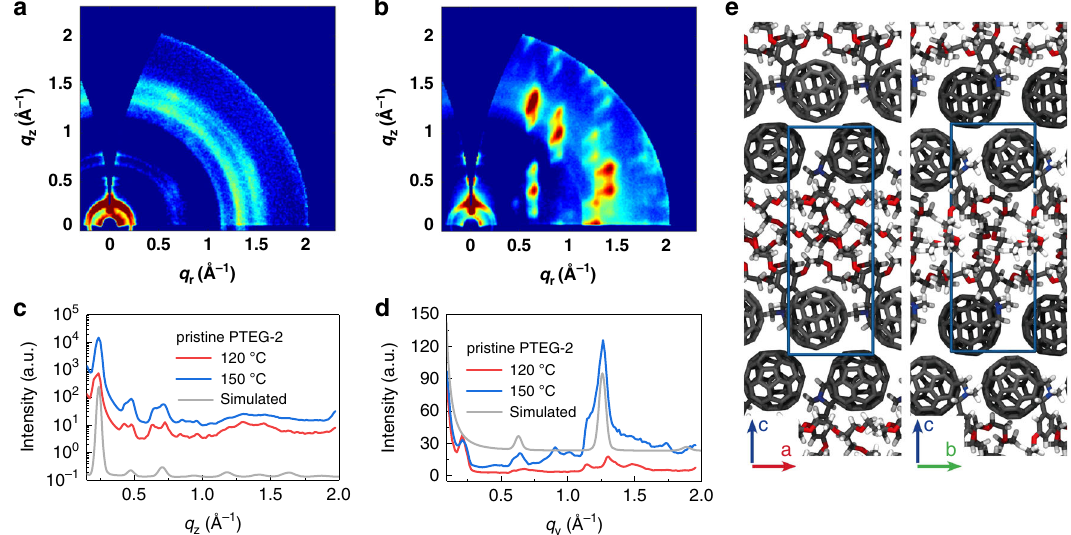
Fig. 3 Molecular packing of PTEG-2 fi lms. a , b 2D-GIWAXS patterns of pristine PTEG-2 fi lms annealed at ( a ) 120 °C and ( b ) 150 °C and ( c , d ) the corresponding linecuts together with the simulated scattering linecuts (the simulated linecuts are plotted on a linear scale in both cases); e representative snapshot of PTEG-2 molecular packing, as atomistically resolved by molecular dynamics simulations; the unit cell is highlighted in